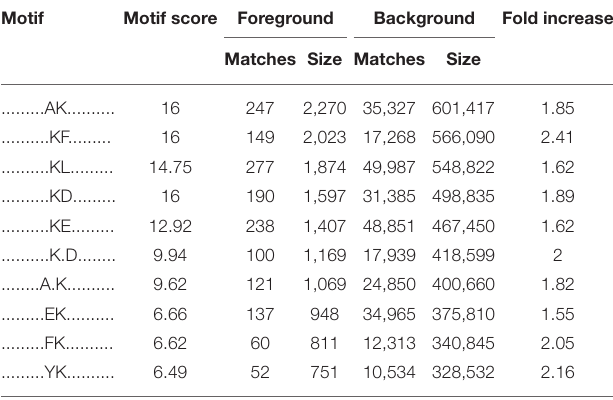
TABLE 4 | The characteristic sequence of the modified site obtained by motif